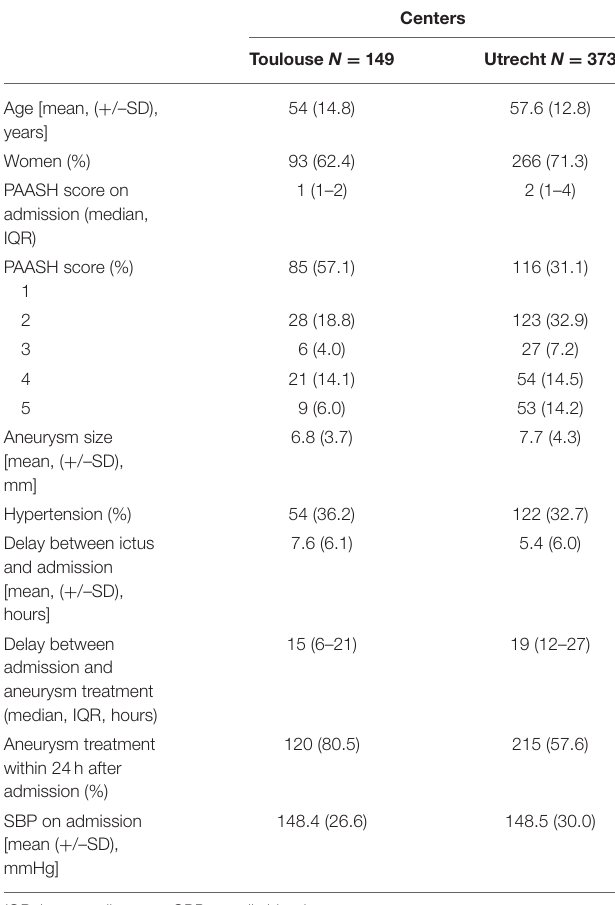
TABLE 1 | Characteristics of the patients from Utrecht and Toulouse.